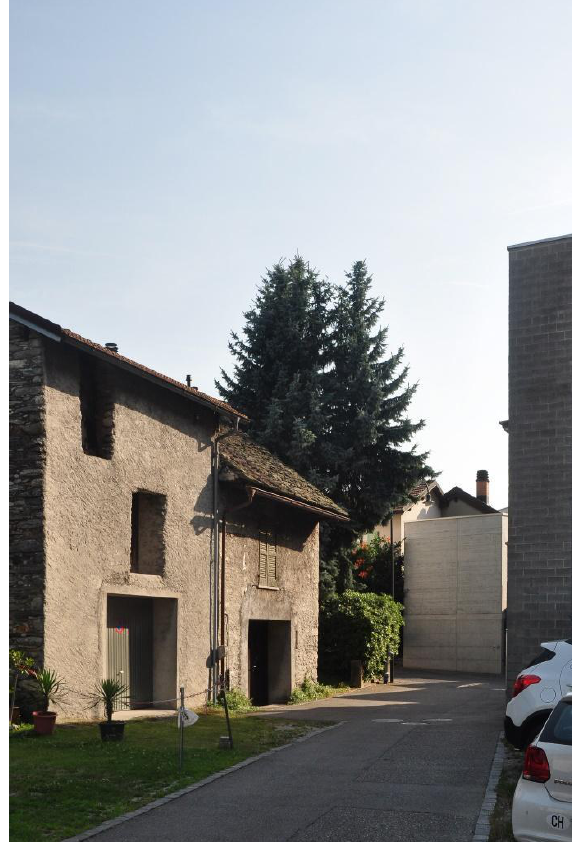
Figure 3. Typical small-town cul-de-sac created by traditional buildings with the significant contribution of those regarded as contemporary (at the end is Casa Stefano Guidotti by Luigi Snozzi). Source: Author.